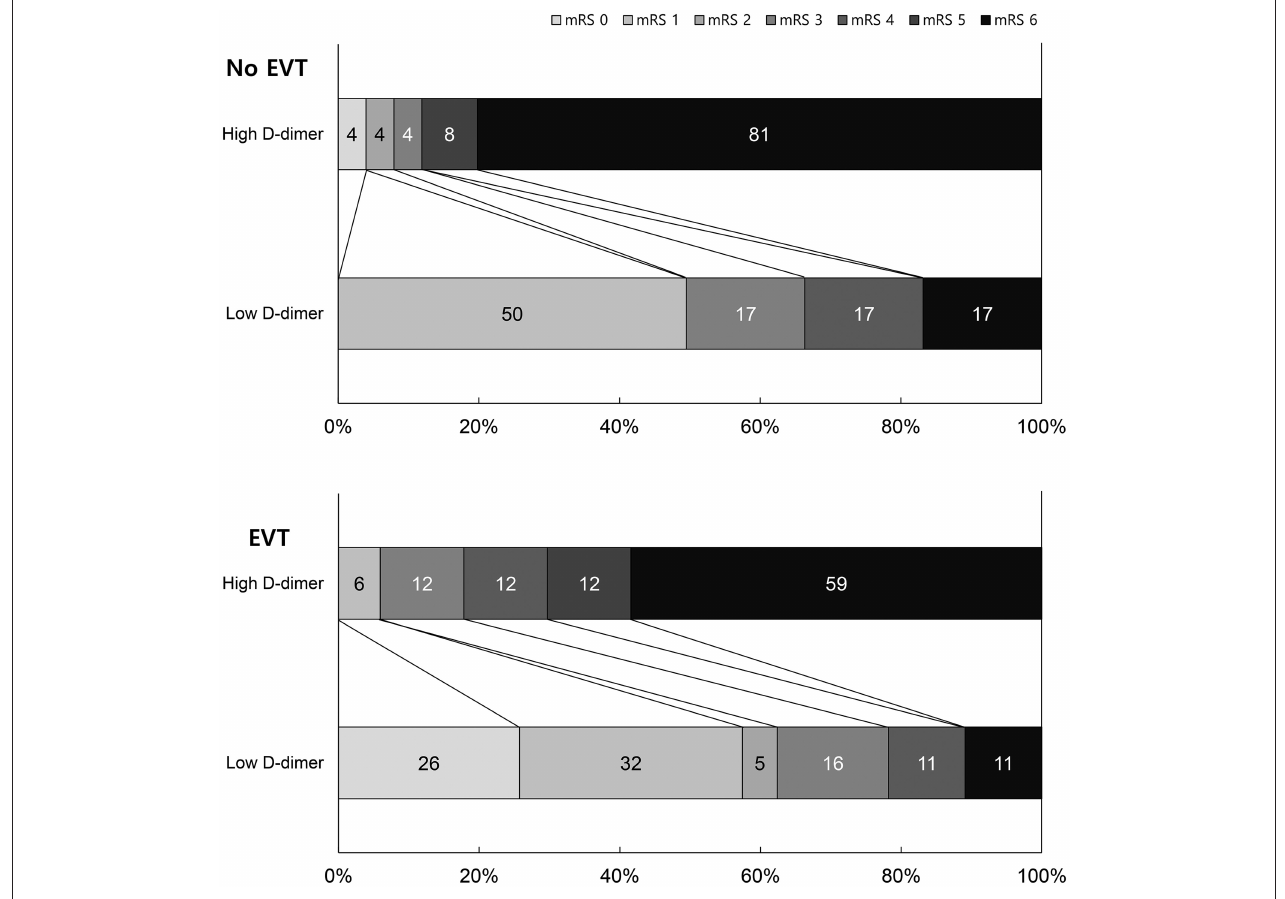
FIGURE 2 | Distribution of modified 3-month Rankin Scale score by EVT and D -dimer